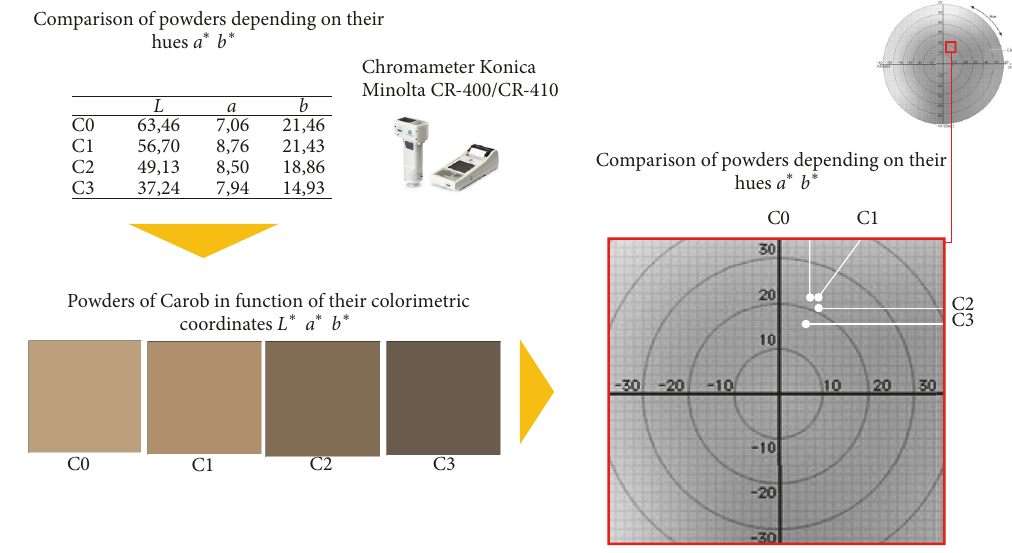
Figure 5: Color assessment of initial and roasted carob pod powders.